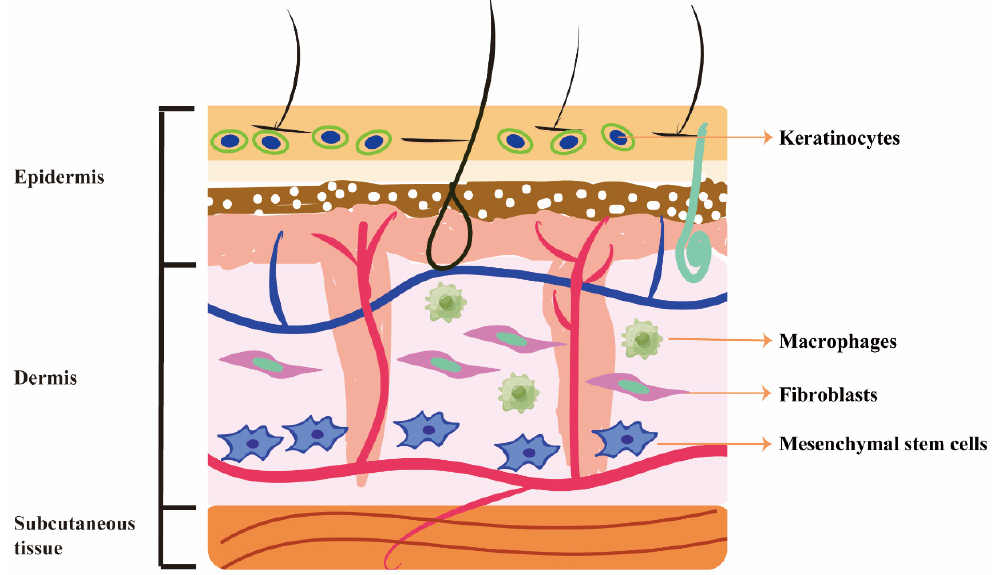
Figure 2. Beneficial cells of RSV in wound